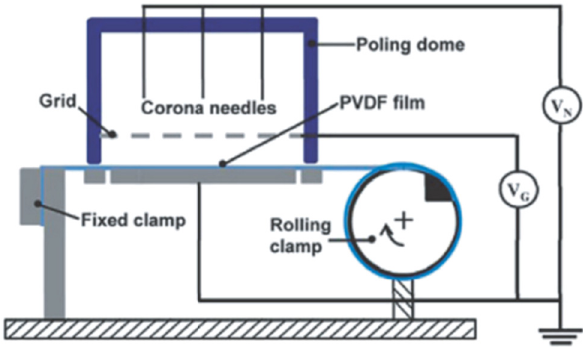
Figure 15: Setup schematic of stretching and corona poling experi - ments [ 130 ]